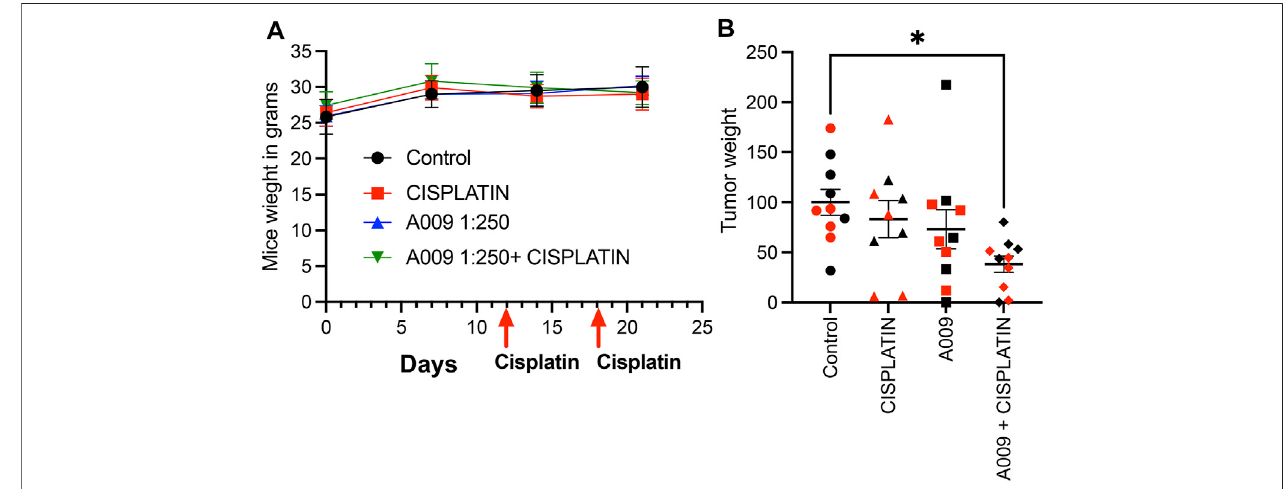
FIGURE 1 | Dietary administration of the A009 extract, in combination with chemotherapy, resulted in both synergism by reducing tumor weight. Dietary administration (drinking water) of A009 extracts synergizes with chemotherapy by reducing tumor weight in vivo . In panel (A) the red arrows indicate the day of administration dose of cisplatin (7 mg/kg), the mice weights did not change. In panel (B) , the effects of the combination of A009 extract with cisplatin (7 mg/kg), was determinedbymeasuringtheweightofthetumorsexcisedfromtheorthotopic invivo modelofprostatecancercellsDU-145(red),22Rv1(black),normalizedtothe control group tumor weight. Data are showed as mean ± SEM, one-way ANOVA, * p <